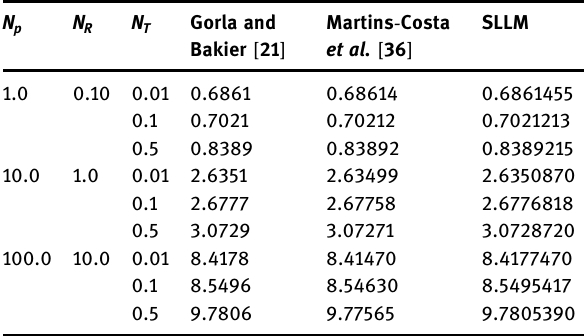
Table 2: Comparison of wall temperature gradient ( ( ) θ − ′ 0 ) for dif - ferent values of N N , p R , and N T when